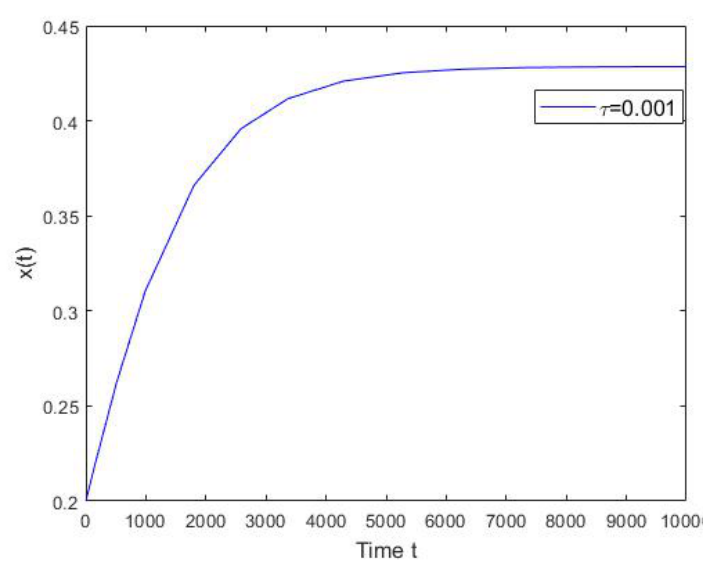
Figure 3. The numerical solution the system in Equation (15), where V = 3 and C = 7.